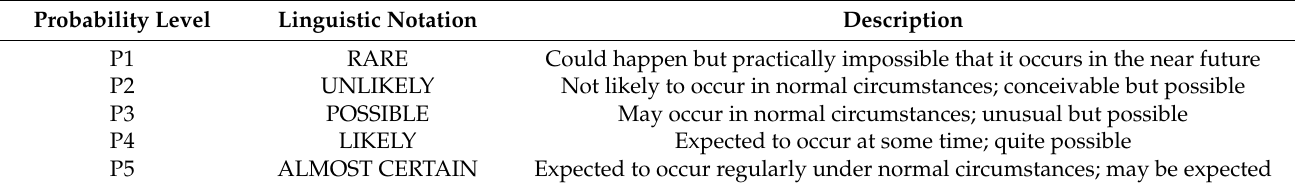
Figure 4. Algorithm for unwanted events occurrence probability estimation. Table 2. Assigning probability levels to linguistic